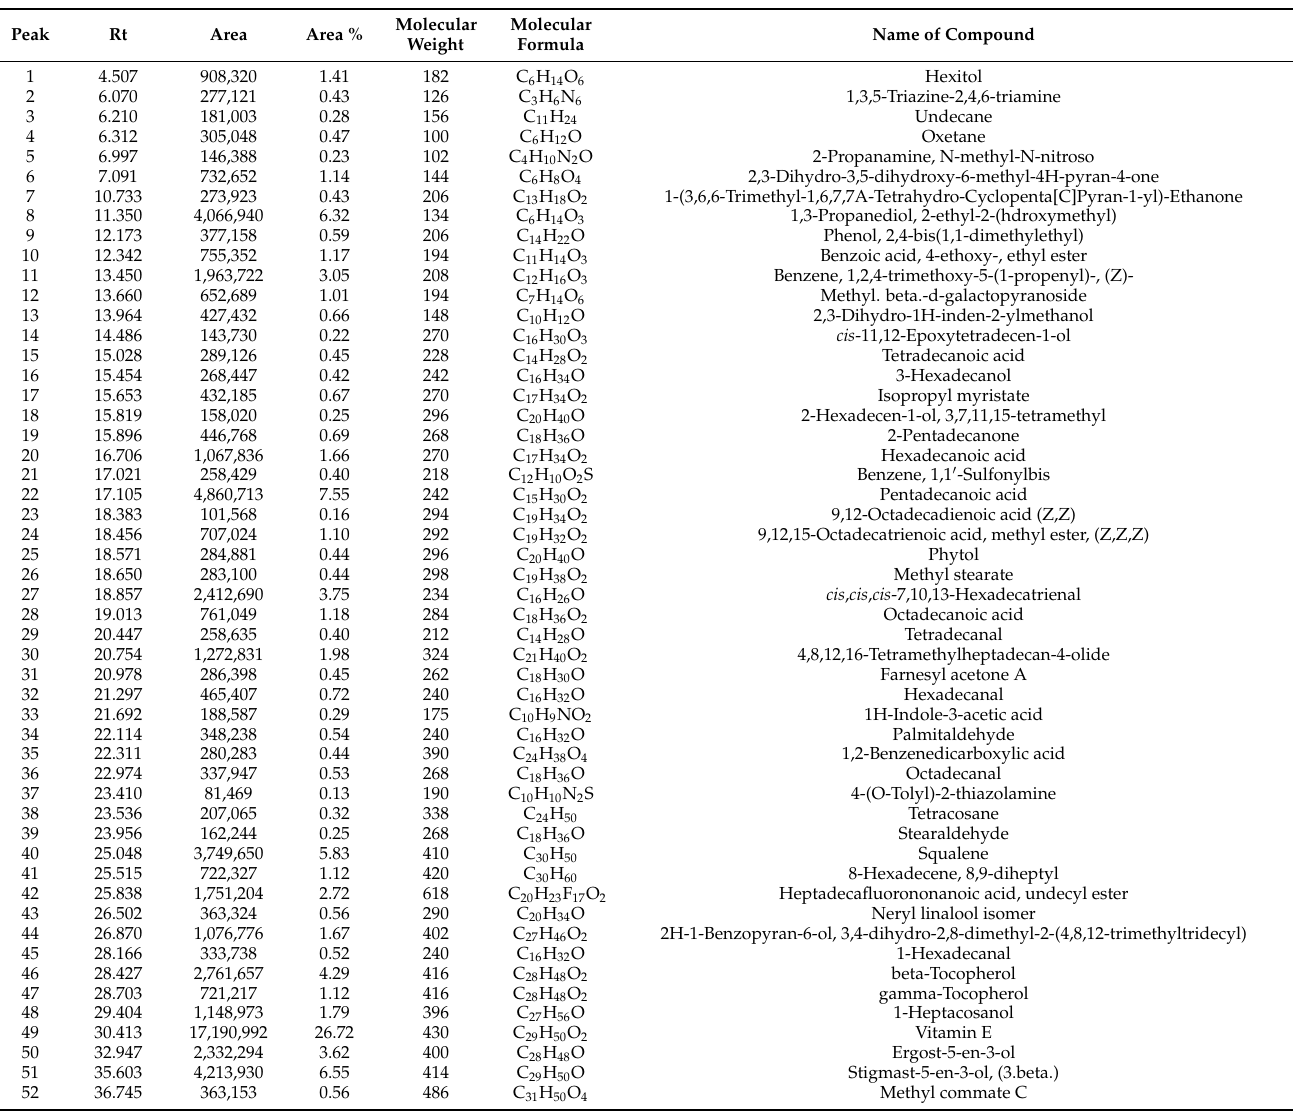
Table 6. Phytoconstituents detected in methanol leaf extract of the mother D. palmatus plant.